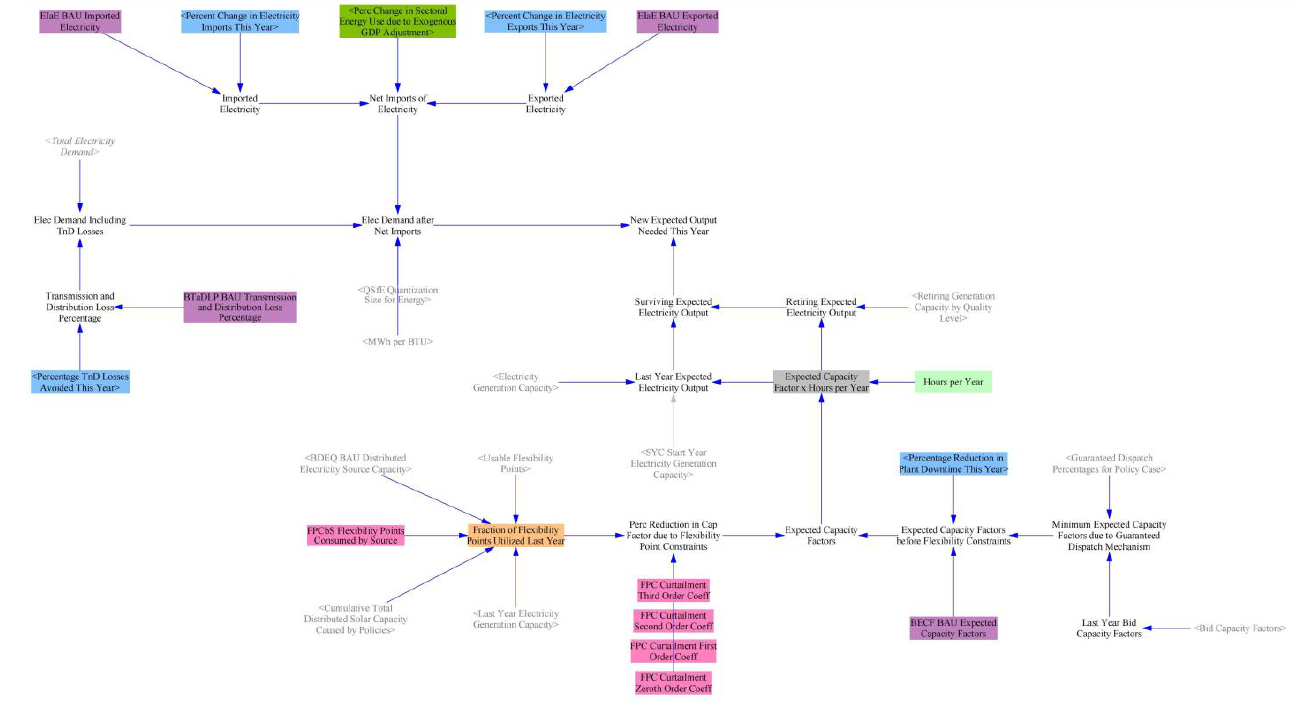
Figure 4. Cause and effect diagram of “power demand determination” in the power sector.